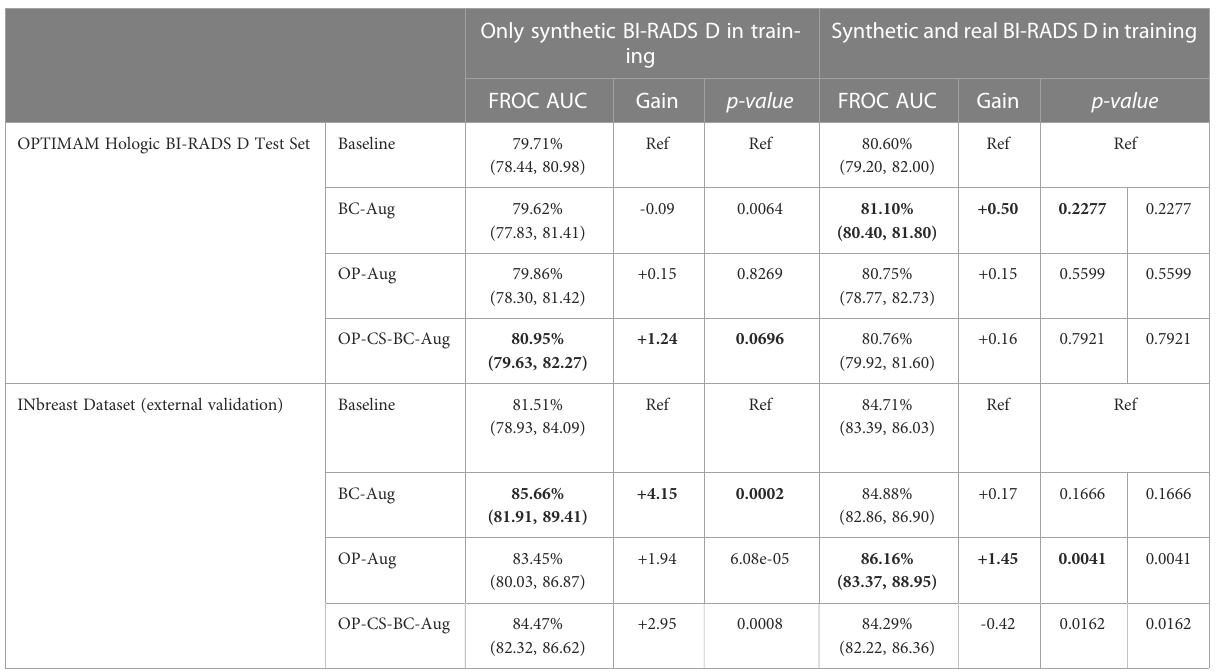
TABLE 3 Performance values and statistical signi fi cance test results of the best data augmentation strategies for the models trained with OPTIMAM Hologic database.